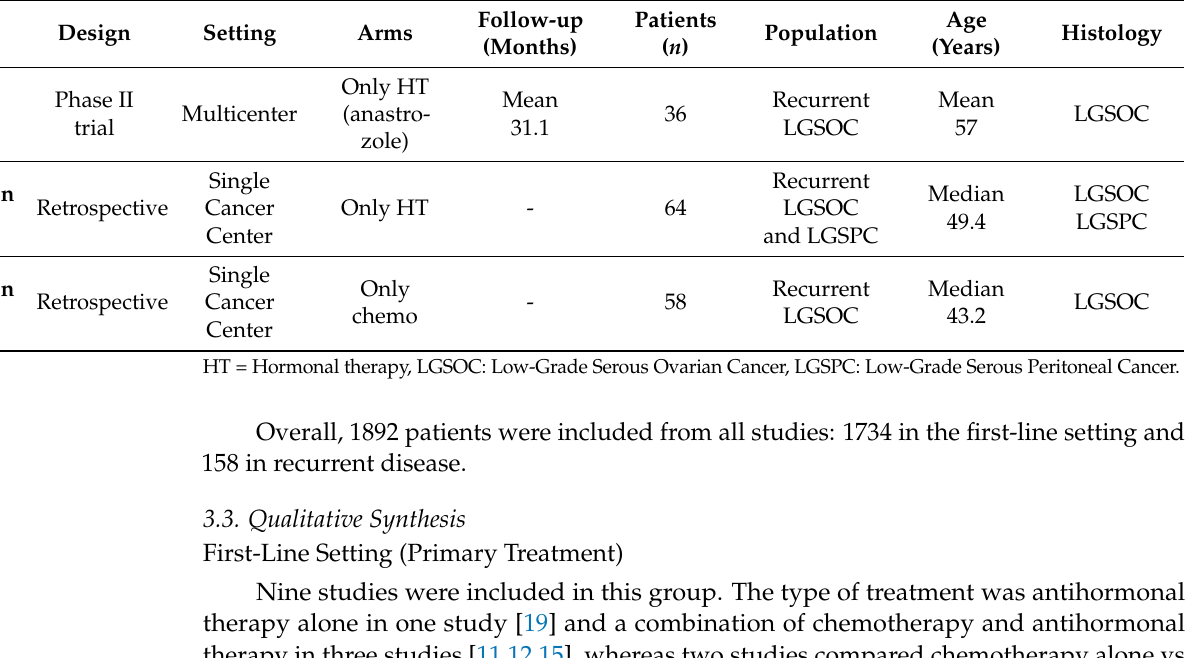
Table 2. Summary of the baseline characteristics of the three included studies for recurrence